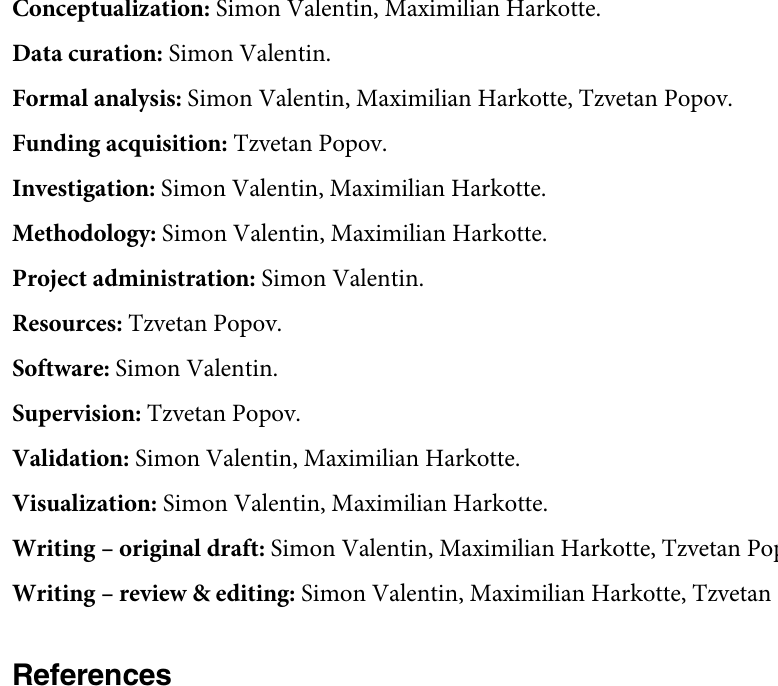
S1 Fig. Model reliance without normalization for group sizes. Results indicate that alpha still emerges as the group of variables that trained models relied upon the most when not accounting for the size of the group of variables. S2 Fig. Classification accuracy for training and testing on individual predictor groups. Results highlight the difference between the relevance and reliance on predictor variables in multivariate models. S3 Fig. Model reliance for SVM models. An RBF kernel function was used for the SVM mod- els and the penalty term C was set to 1. Cross-validated classification accuracy was